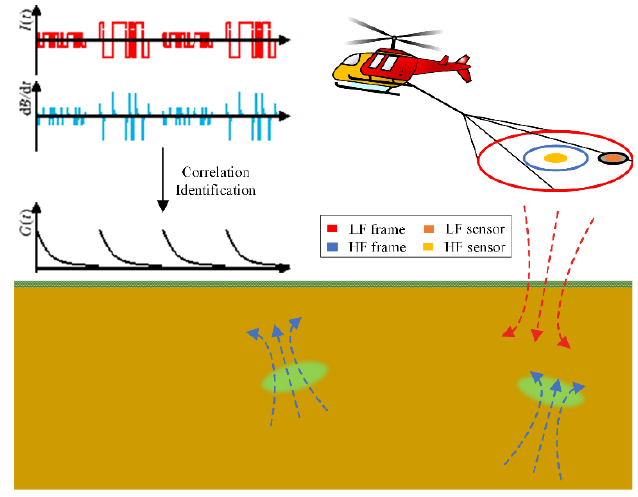
Figure 1. Schematic diagram of the multi-receiver PRBS HTEM system.